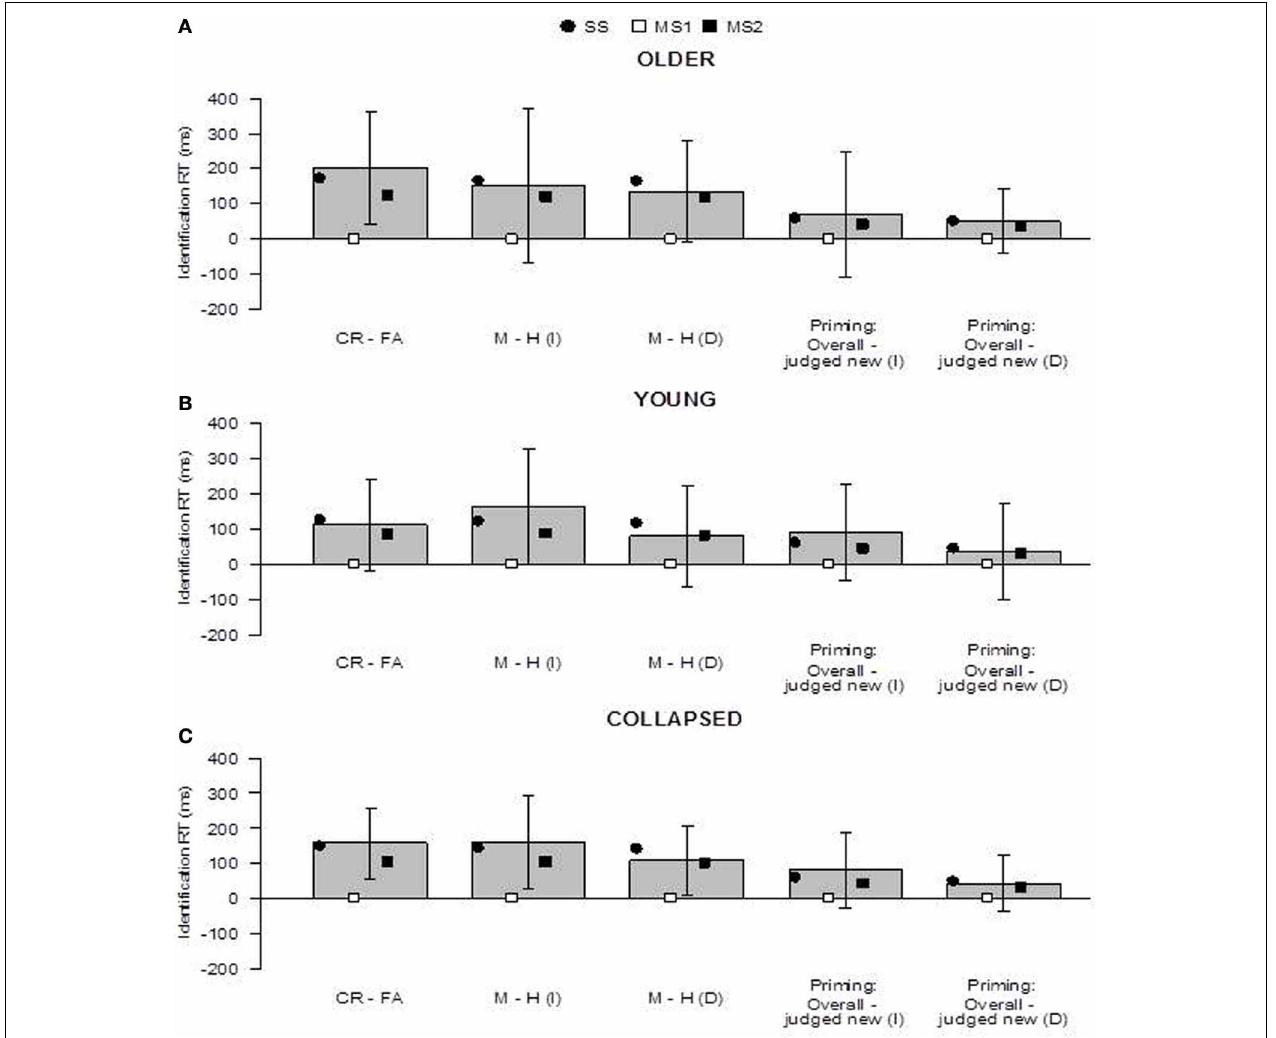
FIGURE 4 | Predictions of the SS, MS1, and MS2 models (Berry et al., 2012) in the older group (panel A), younger group (panel B), and collapsed across groups (panel C). “Priming: Overall - judged new” refers to the difference in the overall priming effect and the priming effect for items judged new. Prediction 1 concerns whether fluency effects occur within new and old items (i.e., CR − FA and